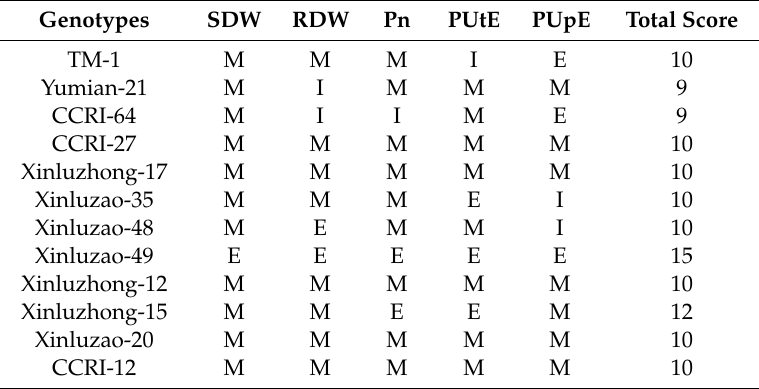
Table 10. Classification of cotton genotypes (grown at P su ffi cient; 500 µ M KH 2 PO 4 ) based on their index scores of various parameters into e ffi cient (E), medium (M), and ine ffi cient (I) scoring